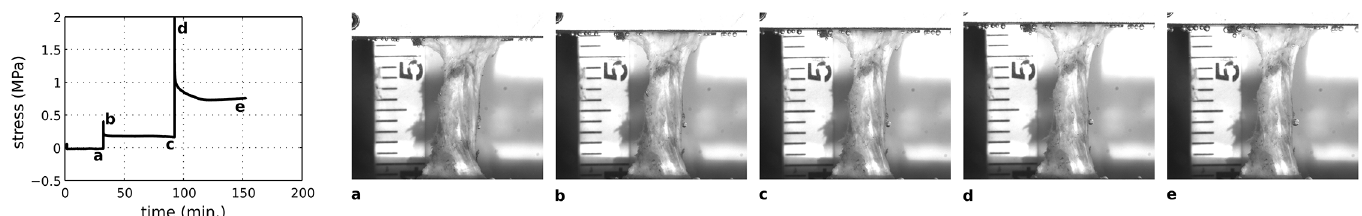
Fig 7. Stress-relaxation response of the anterior cruciate ligament. Tensile stress data is shown along with the visualization of the sample at the beginning and end of the ramp and hold cycles.